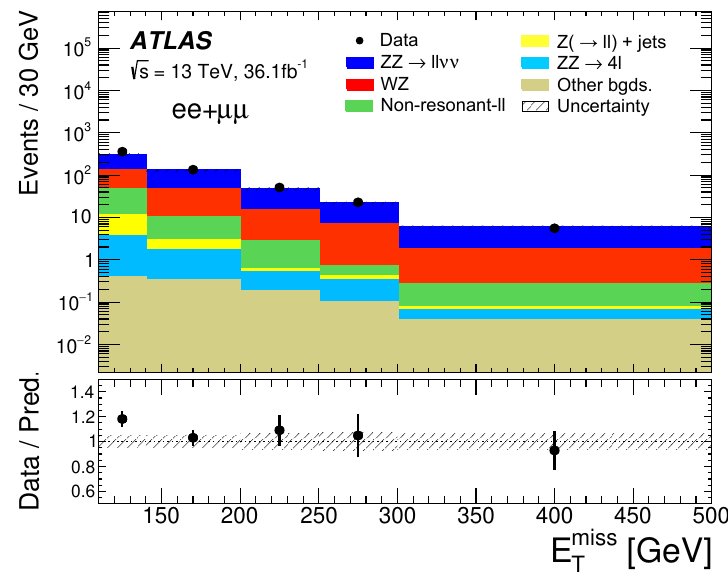
Figure 5 . Observed and expected E miss distributions after the (cid:12)nal selection for the combined ee T + (cid:22)(cid:22) channel before the (cid:12)t procedure. The error bars on the data points correspond to the data statistical uncertainties, and the hashed band for the prediction includes both the statistical uncer- tainties of the simulation and the systematic uncertainties. The \other" background corresponds to the V V V and t (cid:22) tV